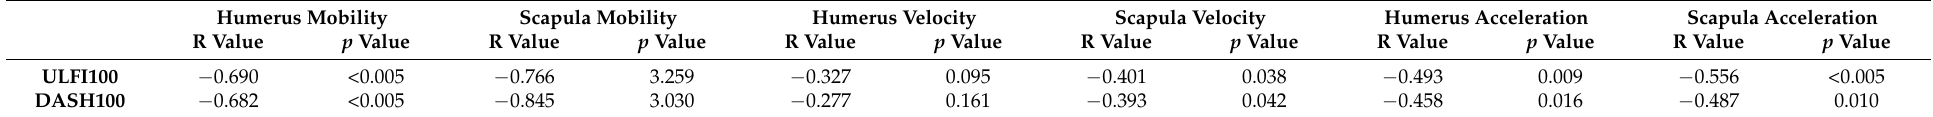
Table 5. Correlation Person Values for symptomatic